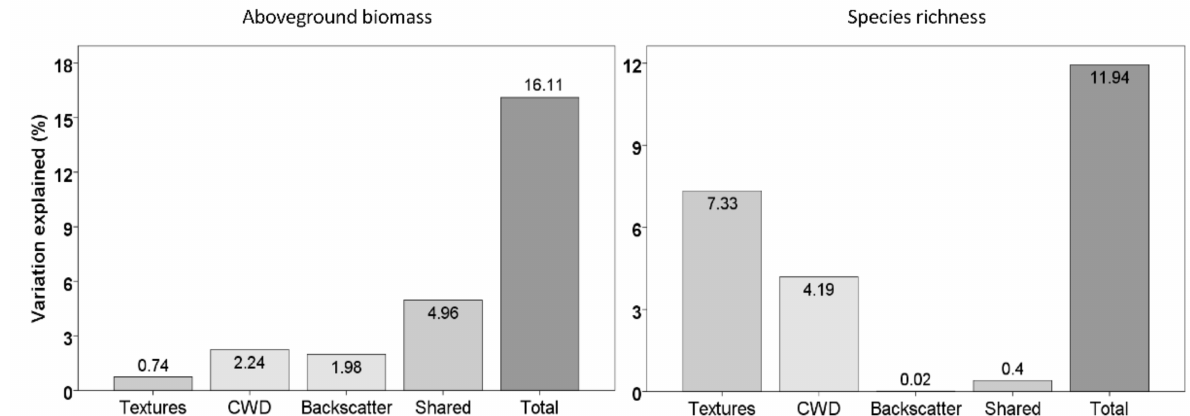
Figure 8. Variance partitioning analysis of the calibrated models to predict aboveground biomass and species richness from three groups of explanatory variables: (1) backscatter (HH, HV and NDBI index), (2) texture metrics from radar and (3) CWD (climatic water deficit).